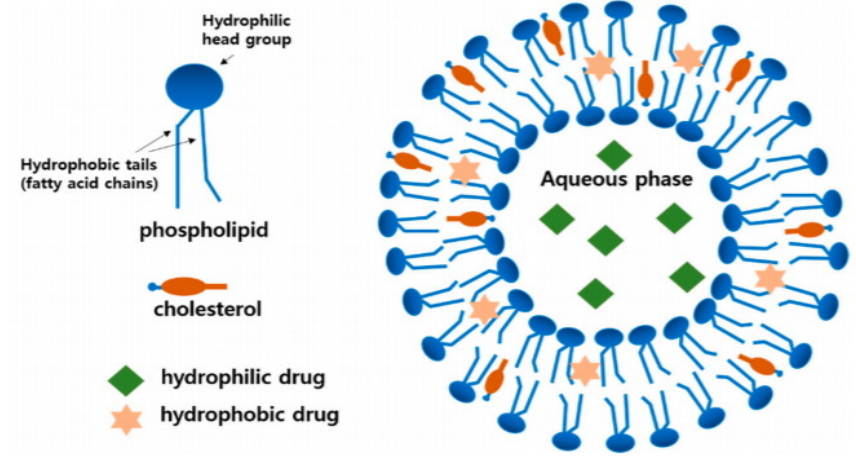
Figure 6. Structure of conventional liposome encapsulating hydrophilic and hydrophobic drugs. Adapted from the reference [152].